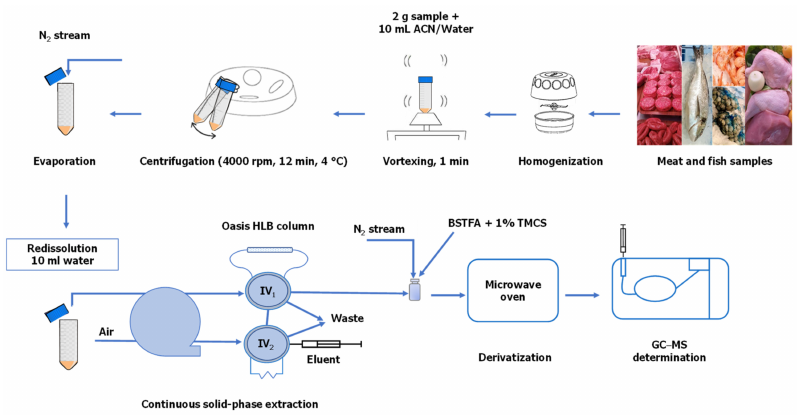
Figure 1. Experimental set-up for the preconcentration, derivatization and determination of natural and synthetic hormones in meat and fish